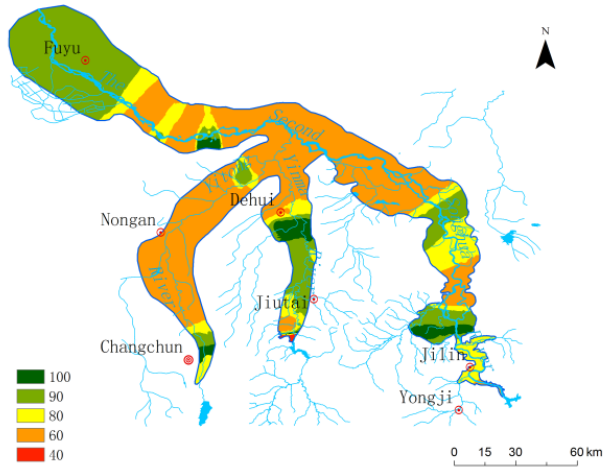
Figure A6. Distribution of hydraulic gradient scores.